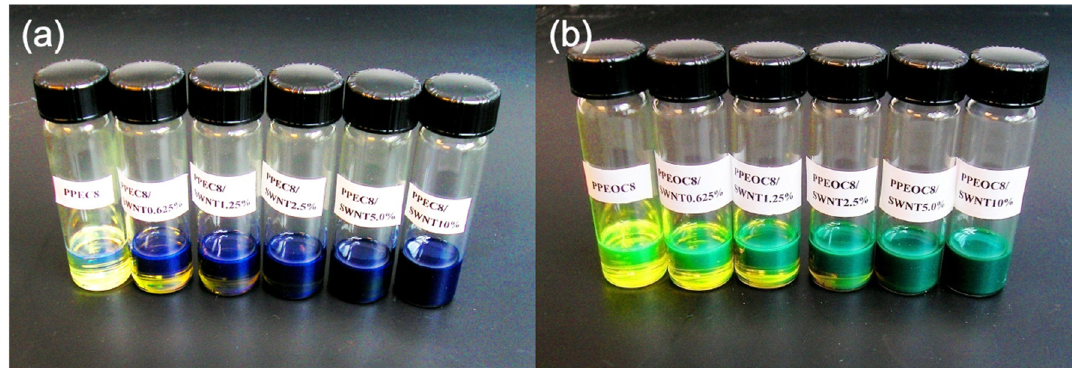
Figure 1. Images of ( a ) PPEC8/SWNT and ( b ) PPEOC8/SWNT nanocomposites in DCB. In each image, SWNT loading relative to PPE amount in the vials from left to right is 0 wt%, 0.625 wt%, 1.25 wt%, 2.5 wt%, 5 wt% and 10 wt%. The PPE concentration is set as 1 mg/mL.